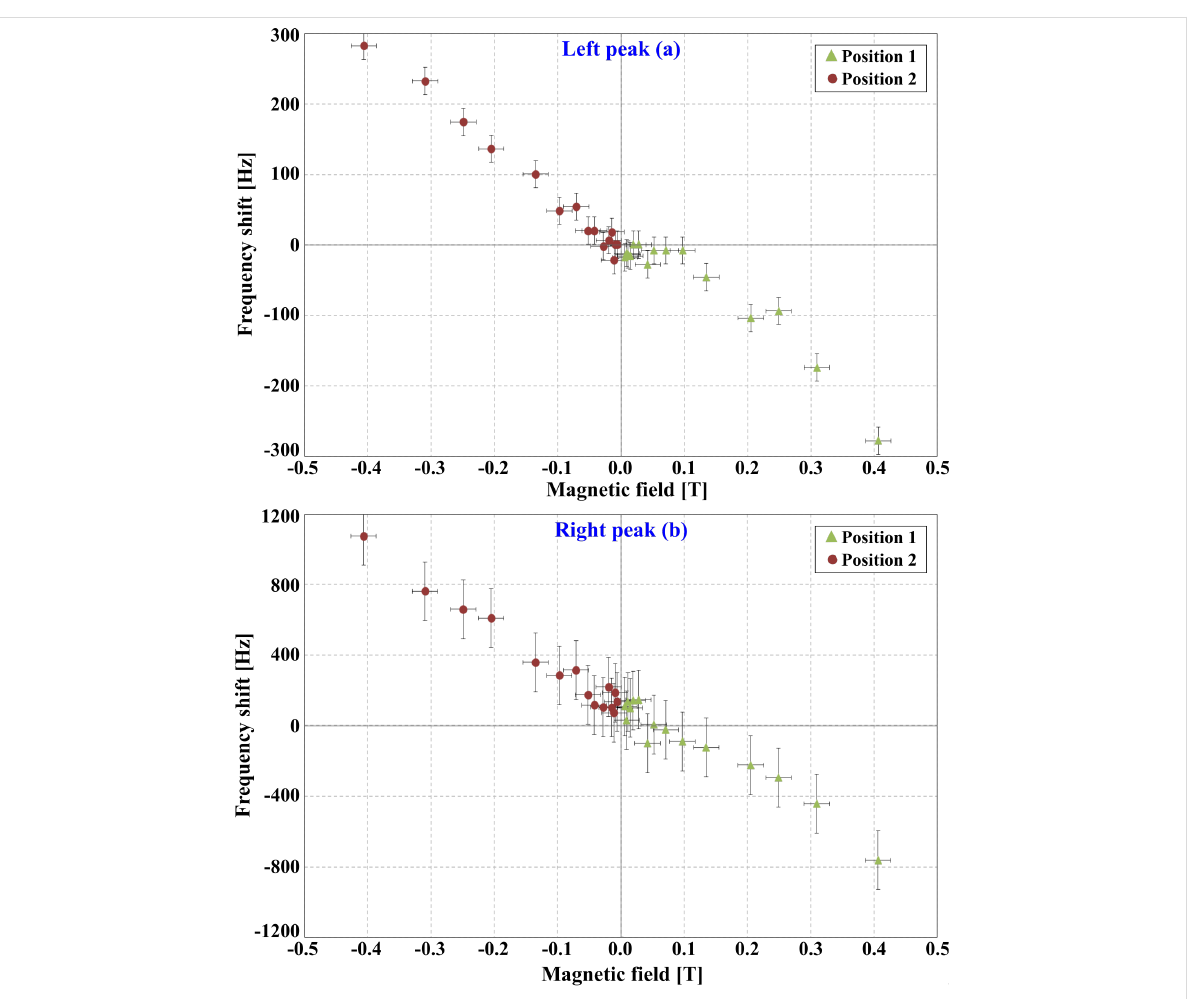
Figure 7: Measured frequency shifts of both peaks (a) and (b) compared to the field free measurement for various magnetic field